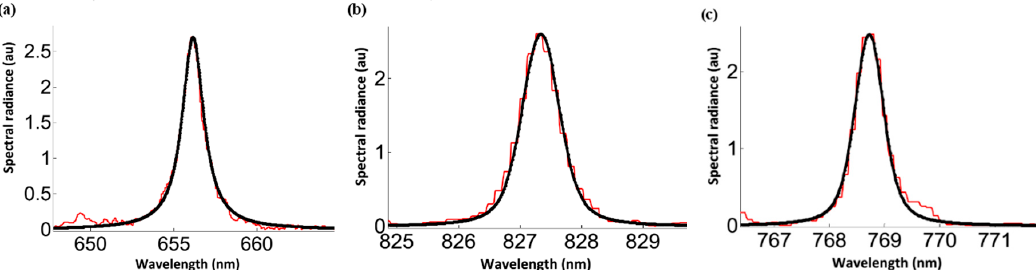
Figure 6. Recorded spectra for ( a ) H α at 656.28 nm, ( b ) Ag I at 827.35 nm, and ( c ) Ag I at 768.7 nm. Laser fluence 9.6 J/cm 2 , 1064-nm excitation. Table 1. Electron densities, n e , in units of 10 17 cm -3 for different fluence, 1064-nm excitation. Laser Fluence (J/cm 2 )